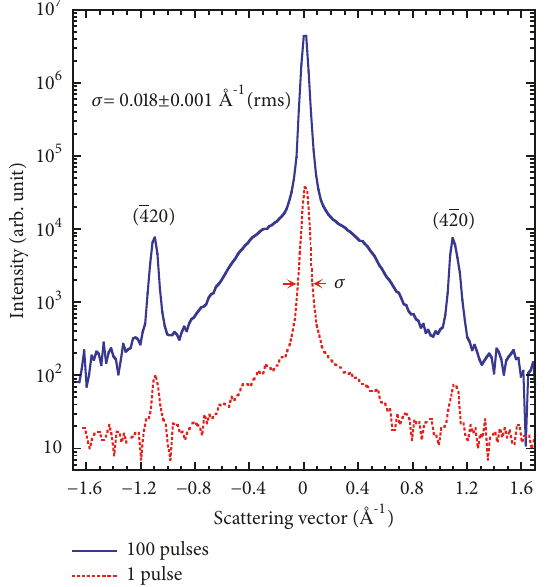
Figure 3: Intensity profiles along the (-420) and (4-20) spots of the images acquired by single-shot (broken curve) and 100-pulse integration (solid curve). The rms width of the (000) spot was obtained as 0.018 ± 0.001 ˚A −1 from the intensity profile of the single- shot image with a Gaussian